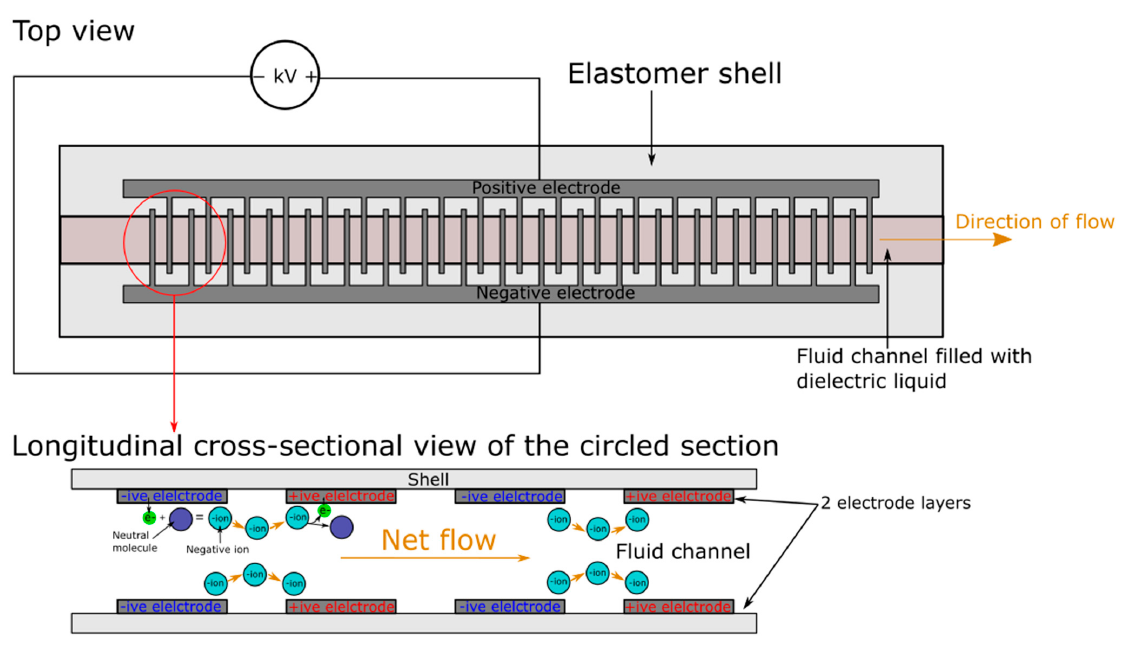
Figure 11. The structure of a basic soft stretchable pump. Illustration inspired by Cacucciolo et al. [111]. There are two comb electrode pairs, one located at the top layer of the shell and the other at the bottom layer. Both electrode pairs are responsible for ionizing liquid molecules and moving the ionized molecules from left to right using electrophoresis.